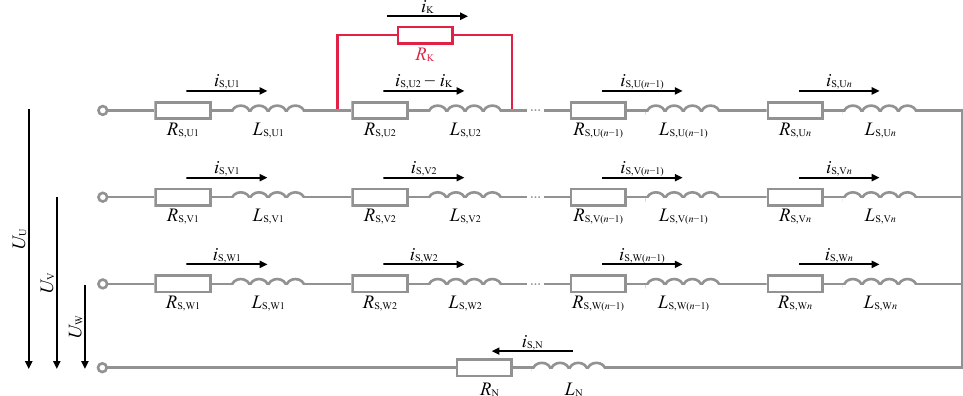
Figure 2. Electrical network of a stator of a squirrel cage induction motor with the phase currents i S and the winding short-circuit path (red) with short-circuit current i K and the resistor R K . The system of electrical equations must be extended by one line with newly introduced matrices, which describe the short-circuit path accordingly. The matrices of the resistance R